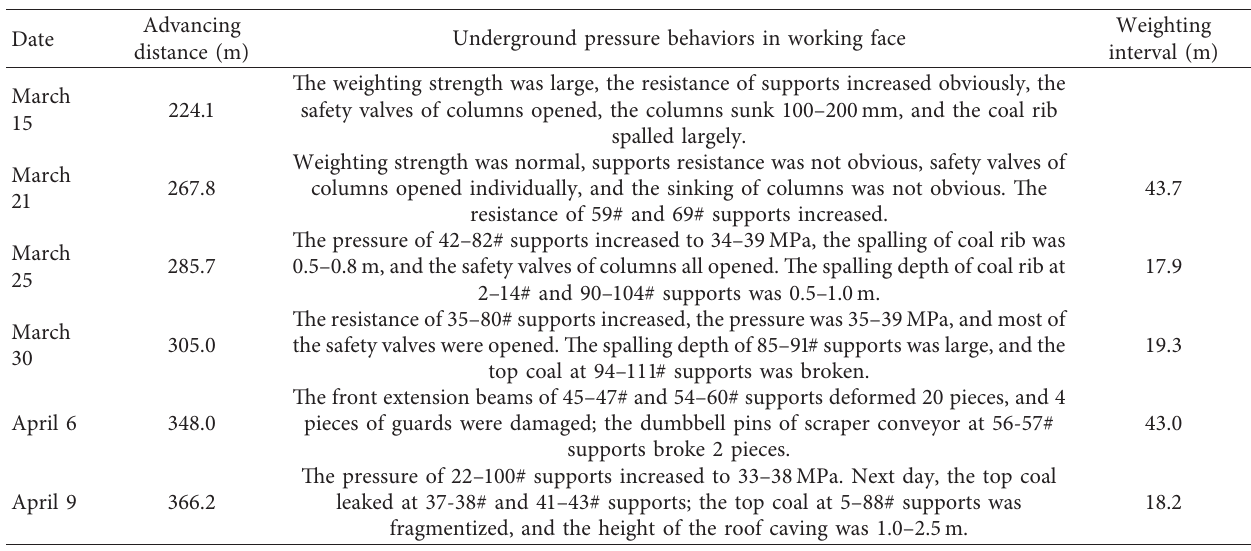
Table 2: The underground pressure behaviors in No. 8100 longwall